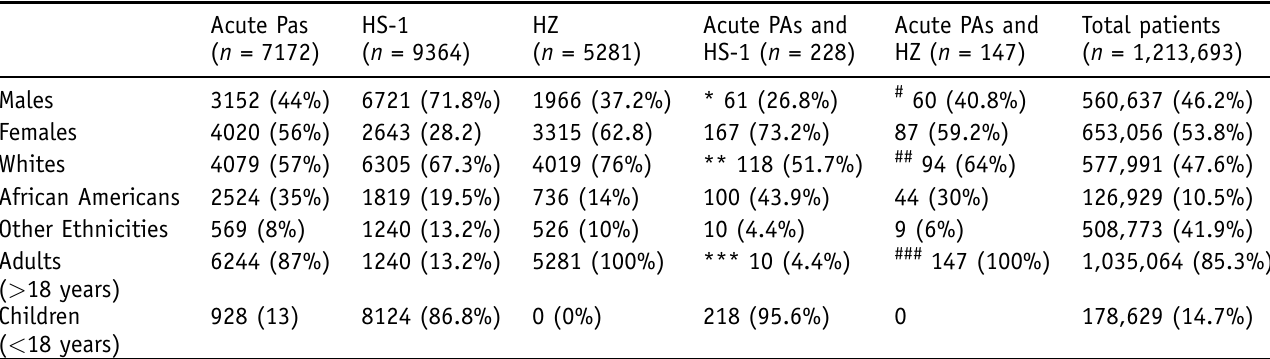
Table I. Demographics of the hospital patient population studied. Pas = periapical abscesses; HS-1 = Herpes Simplex type 1; HZ = Herpes Zoster.